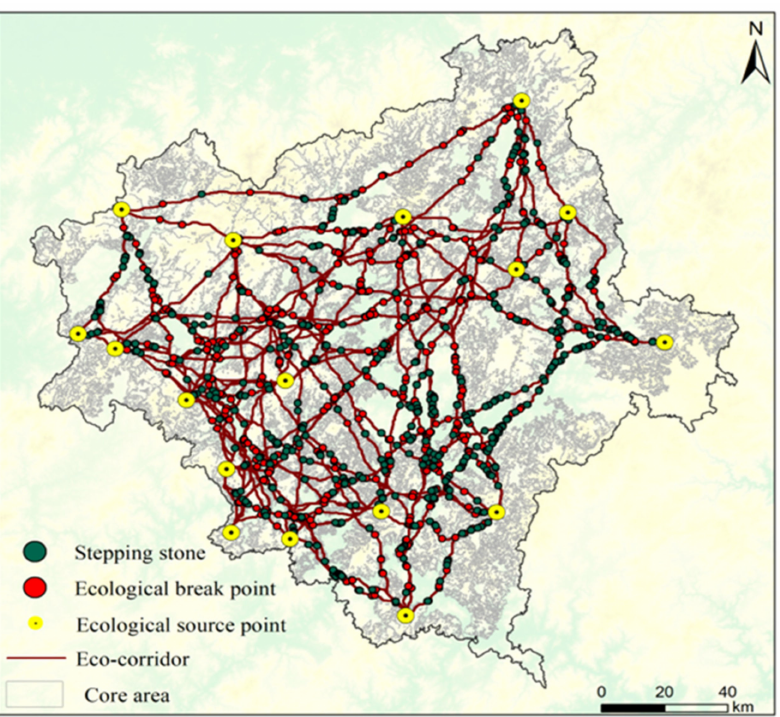
Figure 10. Spatial distribution of the optimized